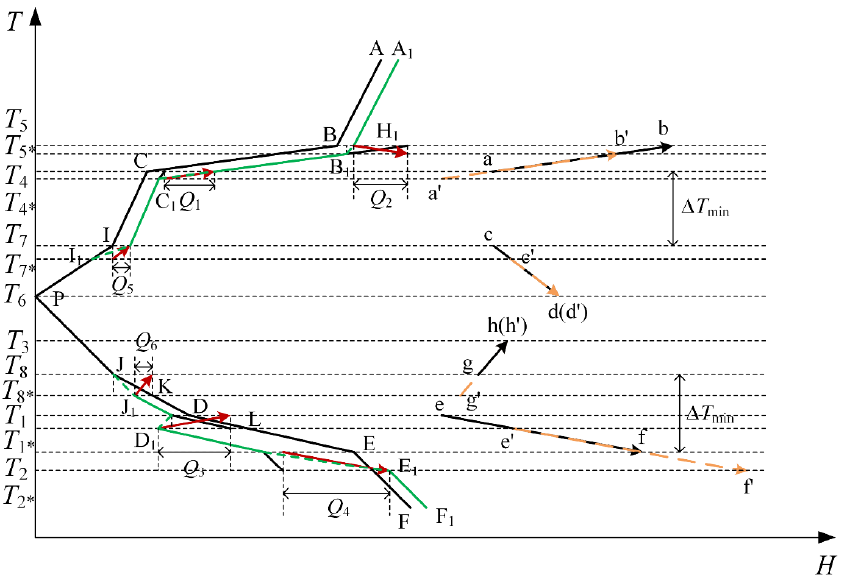
Figure 5. Variation of GCC for Case